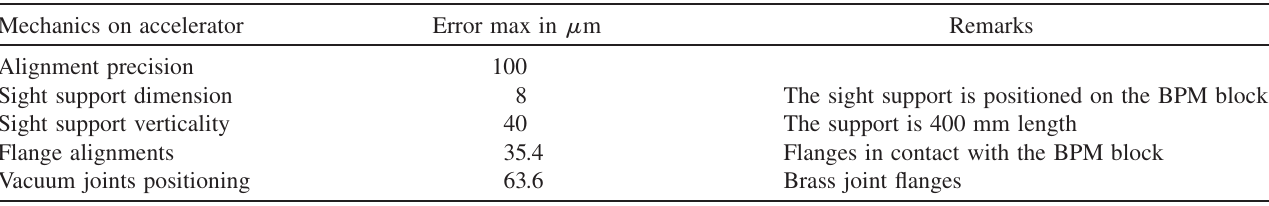
TABLE VII. The position error of the BPM at the accelerator.